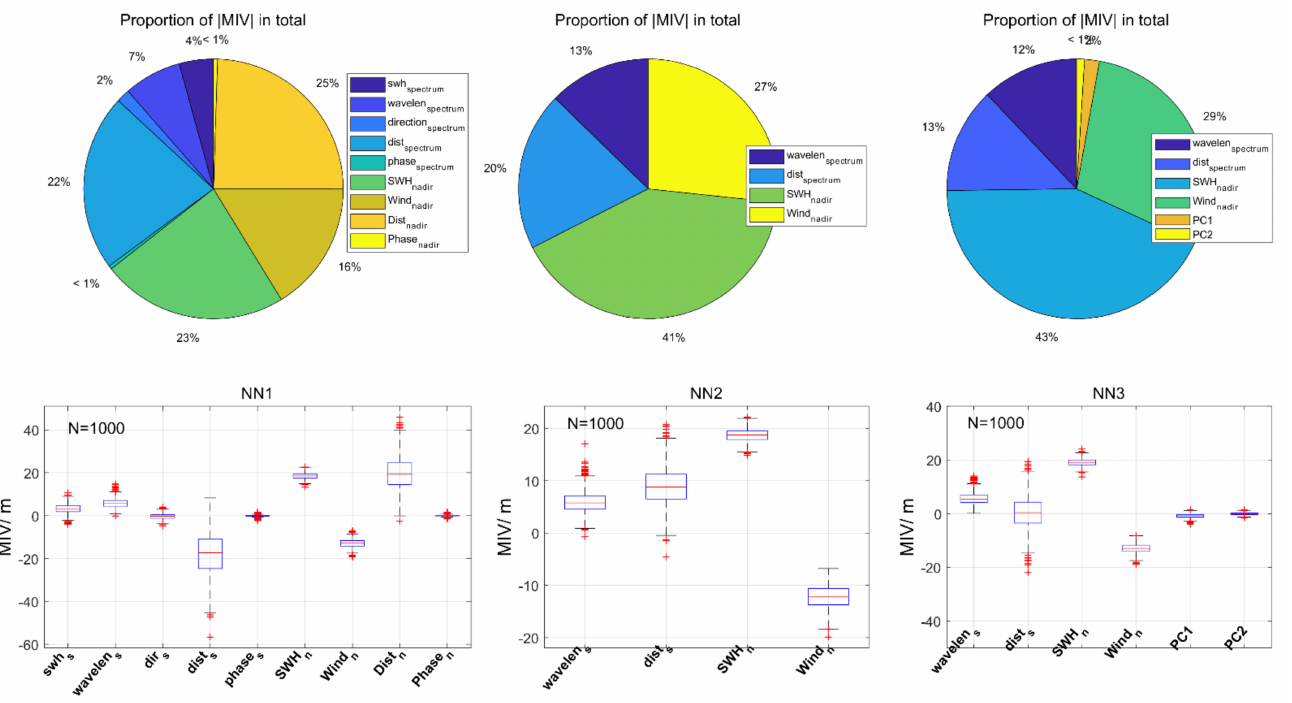
Figure 6. Proportions of PMIV with the median RMSE (upper panels) and boxplots of the MIV were calculated from the three stages NN modeling results (NN1, NN2, and NN3) with 1000 samples from the CFOSAT parameters (Table 1) (lower panels). PC1 and PC2 are the first two PC of the non-critical parameters. Points in red “+” are drawn as outliers if they are larger than the maximum (Q3 + 1.5 × (Q3 − Q1)) or smaller than the minimum (Q1 − 1.5 × (Q3 − Q1)), where Q1 and Q3 are the 25th and 75th percentiles,